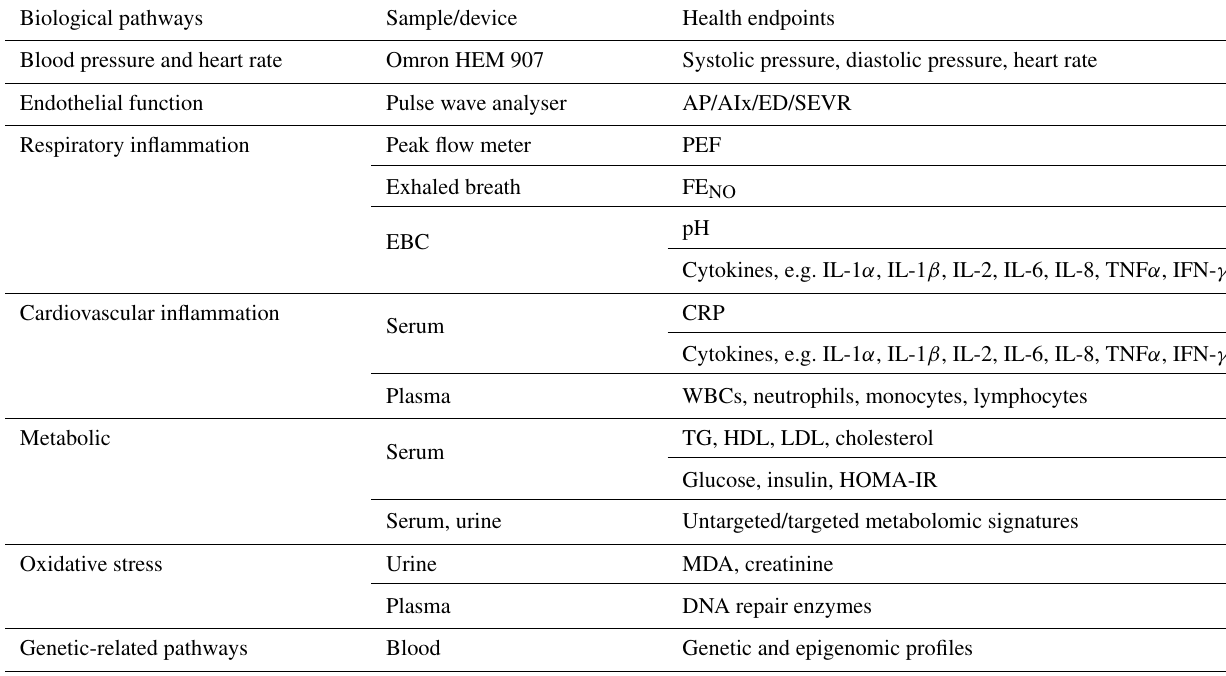
Table 3. Measurement plans for health outcomes in AIRLESS